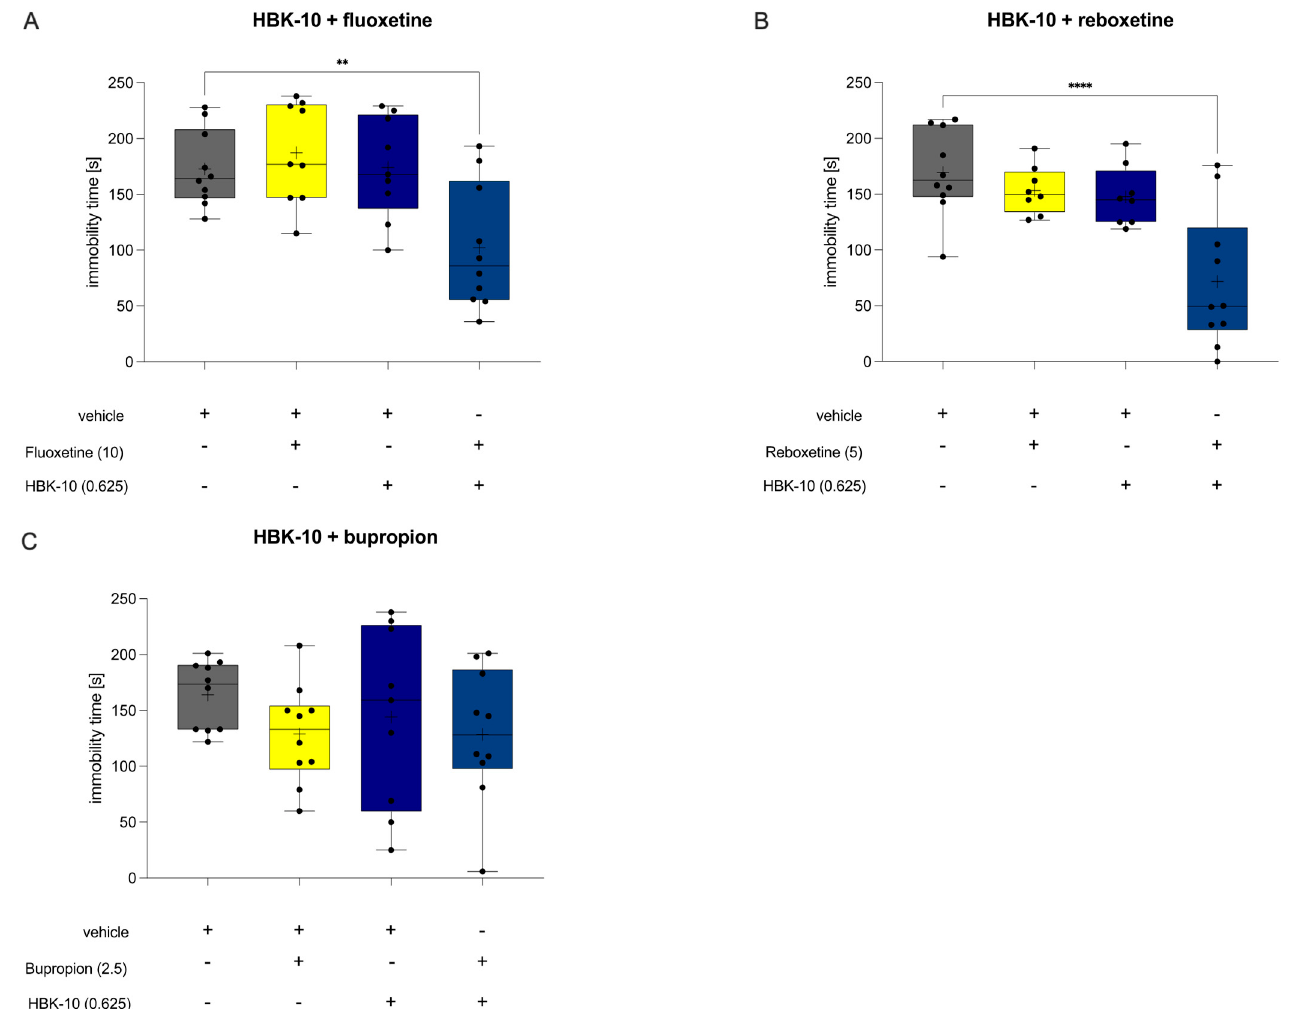
Figure 5. The effect of fluoxetine (Panel ( A )), reboxetine (Panel ( B )), and bupropion (Panel ( C )) on antidepressant-like activity of HBK-10 in the forced swim test in mice. Studied compound and reference drugs: fluoxetine, reboxetine, and bupropion, were administered ip at sub-effective doses 30 min before the test. The results are presented as box plots showing the following data: mean (‘+’), median (horizontal line), upper and lower quartile (the width of the box shows interquartile range), upper and lower extreme (whiskers). Statistical analysis: Shapiro–Wilk test for normality, Brown–Forsythe test for homogeneity of variance, and two-way ANOVA (Newman–Keuls post hoc); ** p < 0.01, **** p < 0.0001; n = 8–10 mice per group.